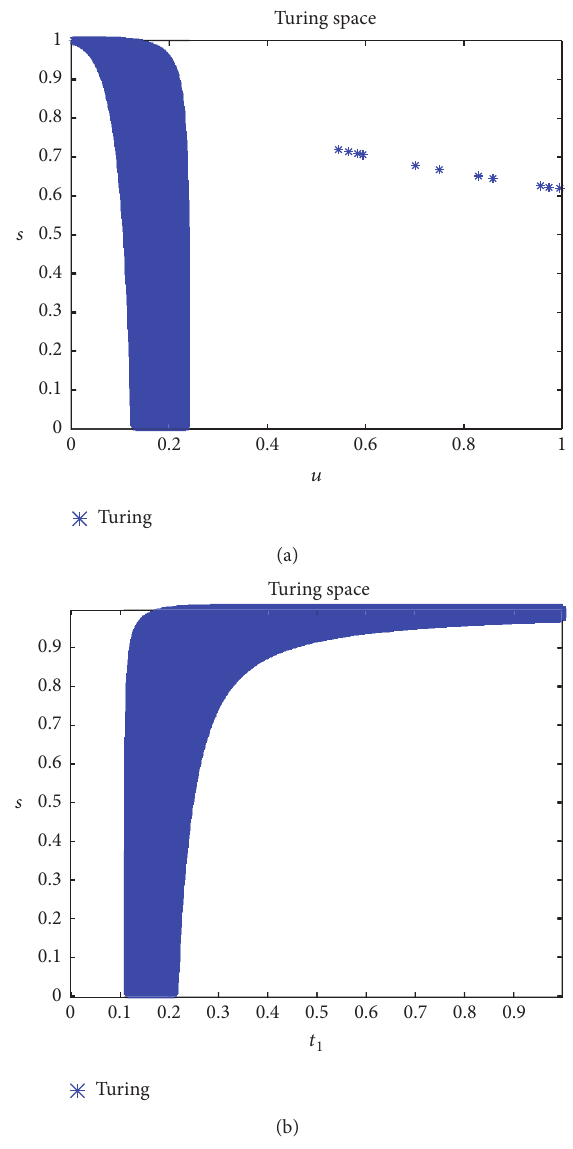
Figure 3: The values of the parameters in (a) are 𝑑 1 = 10 −11 , 𝑑 2 = = 0.9 , 𝛾 = 0.01 , 𝑚 = 0.1 , 𝑟 = 0.01 , 𝑢 = 0.13 . We look at 1.7×10 −8 , 𝑑 3 the Turing space (sensitivity) generated by varying 𝑠 and 𝑢 , each in the range [0, 1] . The values of the parameters in (b) are 𝑑 1 = 10 −11 , = 1.7 × 10 −8 , 𝑑 = 0.9 , 𝛾 = 0.01 , 𝑟 = 0.1 , 𝑢 = 0.13 , 𝑚 = 0.1 . We 𝑑 2 3 look at the Turing space (sensitivity) generated by varying 𝑠 and 𝑡 1 , each in the range [0,1]